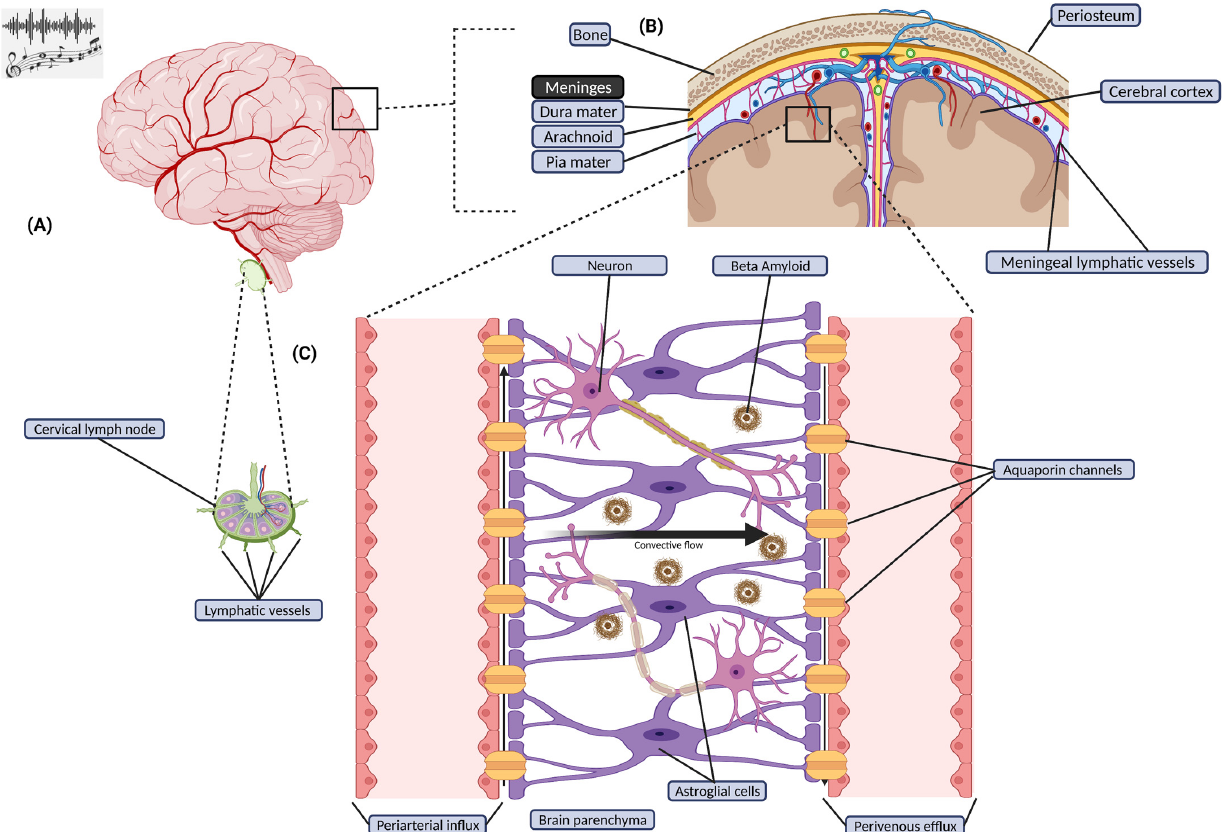
Figure 1. Glymphatic/Meningeal Lymphatic System Process. Illustration of the glymphatic/meningeal lymphatic system in terms of the cerebrospinal fluid (CSF) and the movement of solutes in and out of the brain. An expanded view is provided to allow for a better understanding of the process involved with the meningeal lymphatic vessels in reference to the blood–brain barrier and the flow of CSF. ( A ) Music/sound exposure in the scope of brain structure in terms of the CSF as paravascular influx is involved in the meningeal lymphatic system exchange from arteries to veins. A deep cervical lymph node representation is shown in which meningeal lymphatic vessels originate from within the neck. Nodes are involved with waste elimination based on lymph flow and perivenous efflux pathways. ( B ) A zoomed-in representation of brain meninges in which the meningeal lymphatic vessels are located in the subarachnoid space containing the CSF. A clear separation of meningeal lymphatic anatomy and its process is depicted compared to its counterpart, the glymphatic system residing in vessels in the brain tissue, as shown in panel C. ( C ) A zoomed-in representation of the glymphatic system based on the perivascular space in brain tissue. Brain circulation in terms of periarterial influx and perivenous efflux provides a pathway for solute waste clearance. The pia mater layer is tied with astrocytes and aquaporin-4 channels (AQP4). CSF influx through periarterial space into arteries allows AQP4 water pump function to drive CSF/interstitial fluid (ISF) exchange within the brain parenchyma. The convective flow of CSF/ISF exchange drives interstitial solutes through opposite AQP4 channels and through paravenous spaces into venous vessels as efflux essentially clears solutes/waste from the